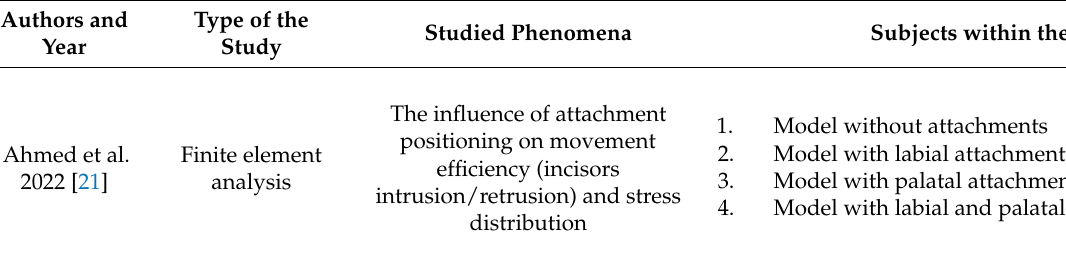
Table 2. Included studies regarding influence of composite attachment presence on movement